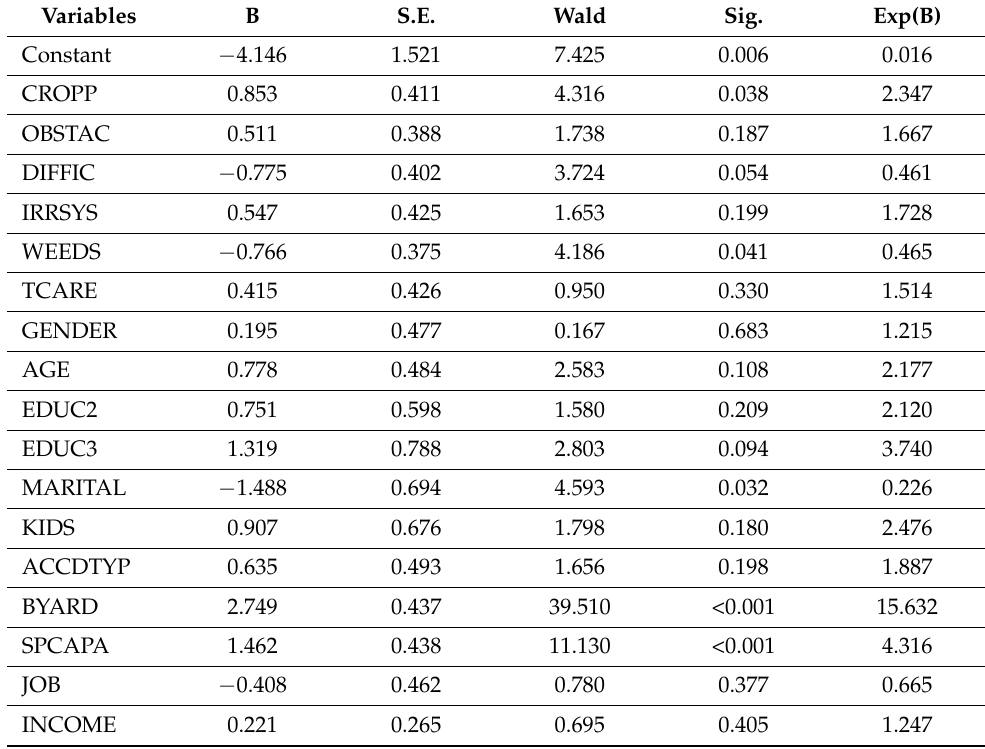
Table 4. The Analysis of the Factors Affecting Householders Willingness to Have Home Garden